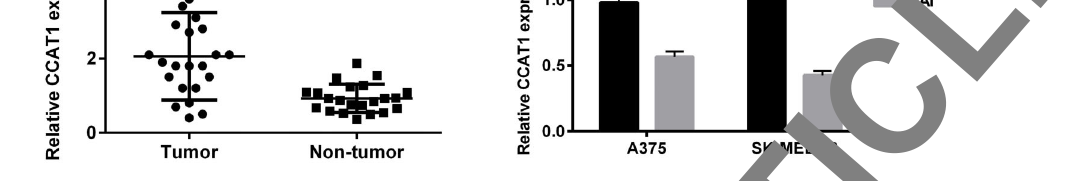
Figure 3. CCAT1 was up-regulated in melanoma tissues and down-regulated by baicalein (BAI) in melanoma cells. A , Expression of CCAT-1 in malignant melanoma tissues (n=22) and non-tumor skin specimens (n=22) was analyzed by RT-qPCR. B , Expression of CCAT-1 in malignant melanoma cells after treating with BAI or not was determined by RT-qPCR. Data are reported as mean ± SD. ***P o 0.001 ( t -test). CTRL: control.